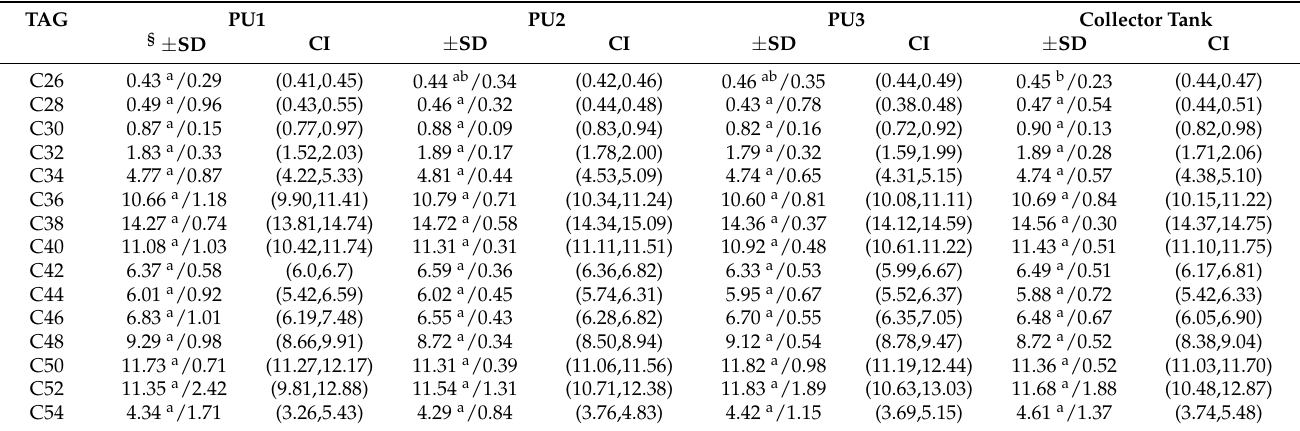
Table 1. Composition of triacylglycerides (% w / w ) in organic milk from the municipality of Tecpat á n, Chiapas.